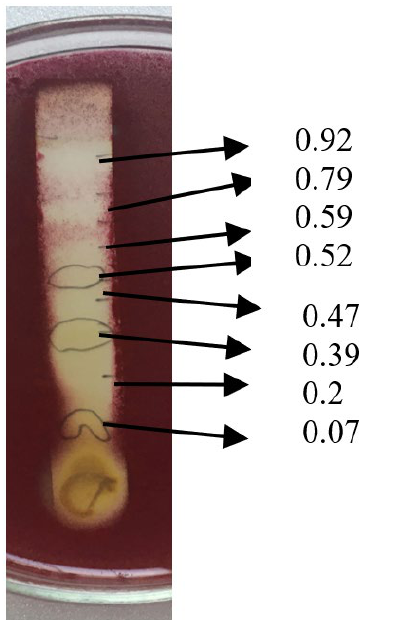
Fig. 10. Agar overlay bioautography of acetone extract of T.catappa leaf showing inhibition of S.typhi (MTCC 733) at Rf values 0.92, 0.79, 0.59, 0.52, 0.47, 0.39, 0.2 and 0.07.